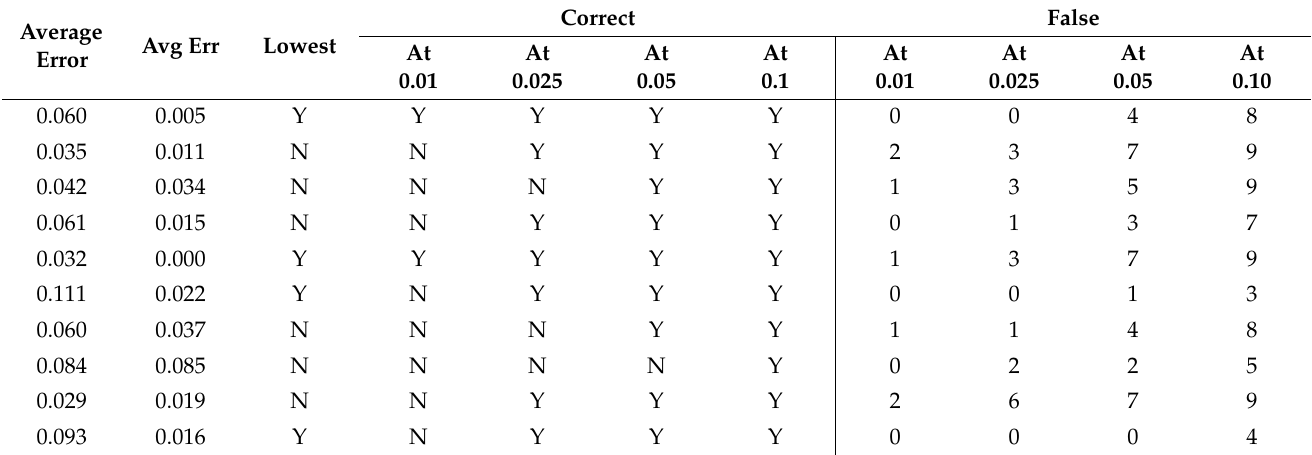
Table A198. Set 3, trials 21–30 summary data (single 0.5 PR value).